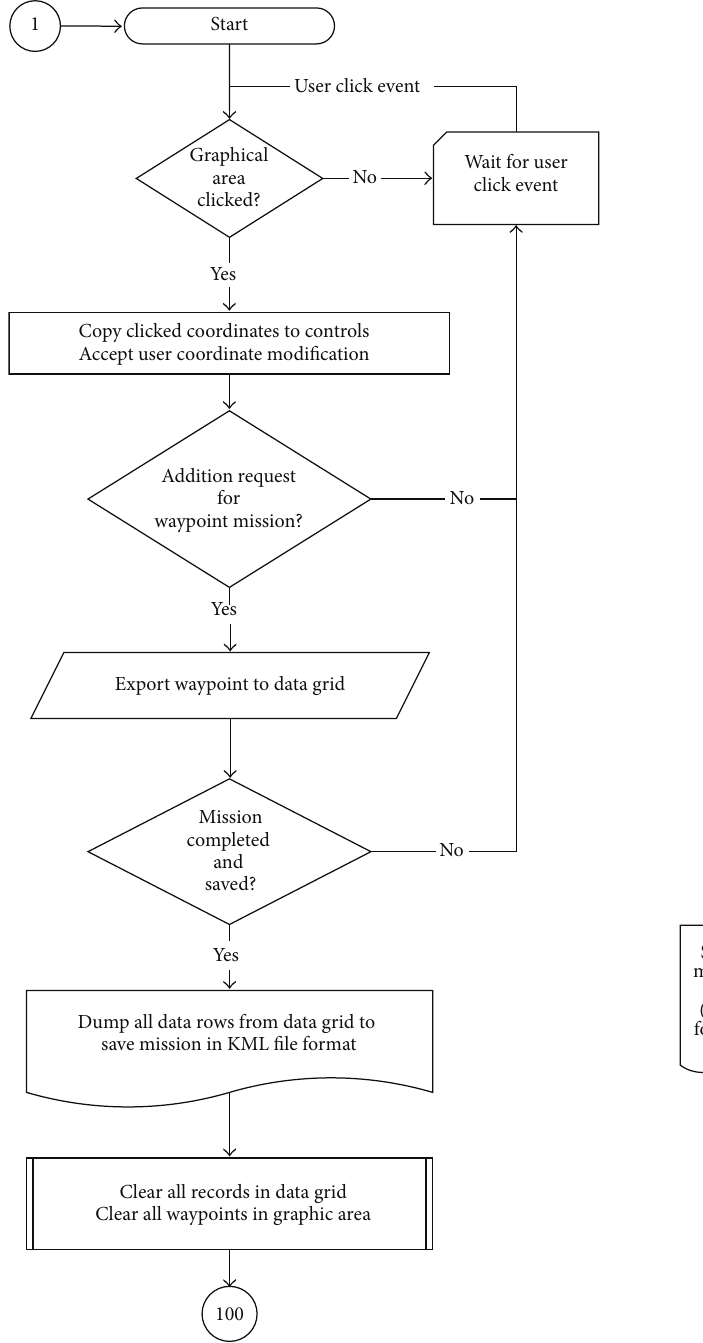
Figure 2: Proposed mission designer flowchart.